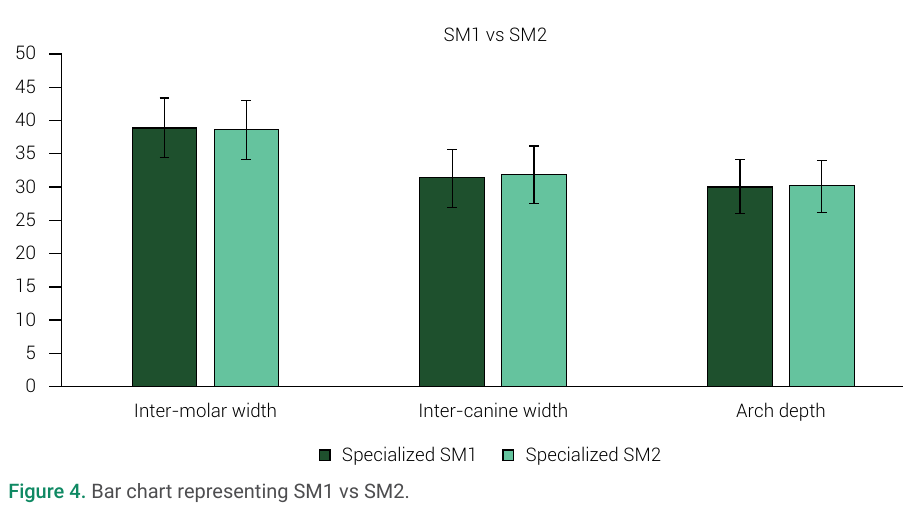
Figure 4. Bar chart representing SM1 vs SM2.